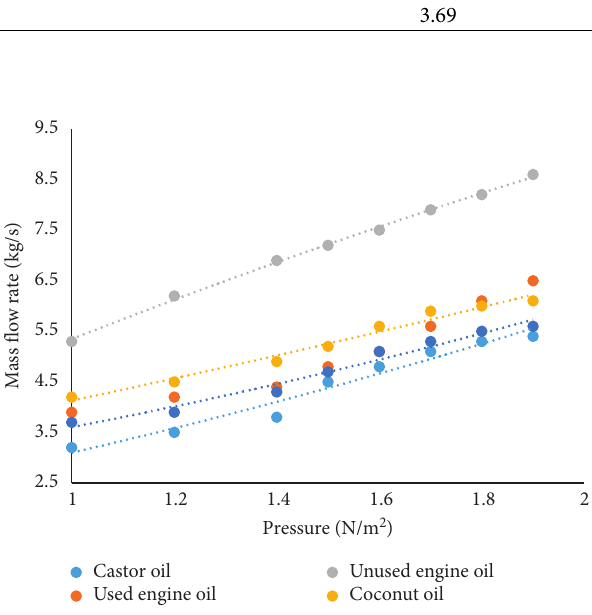
Figure 6: Mass flow rate of steam against pressures of